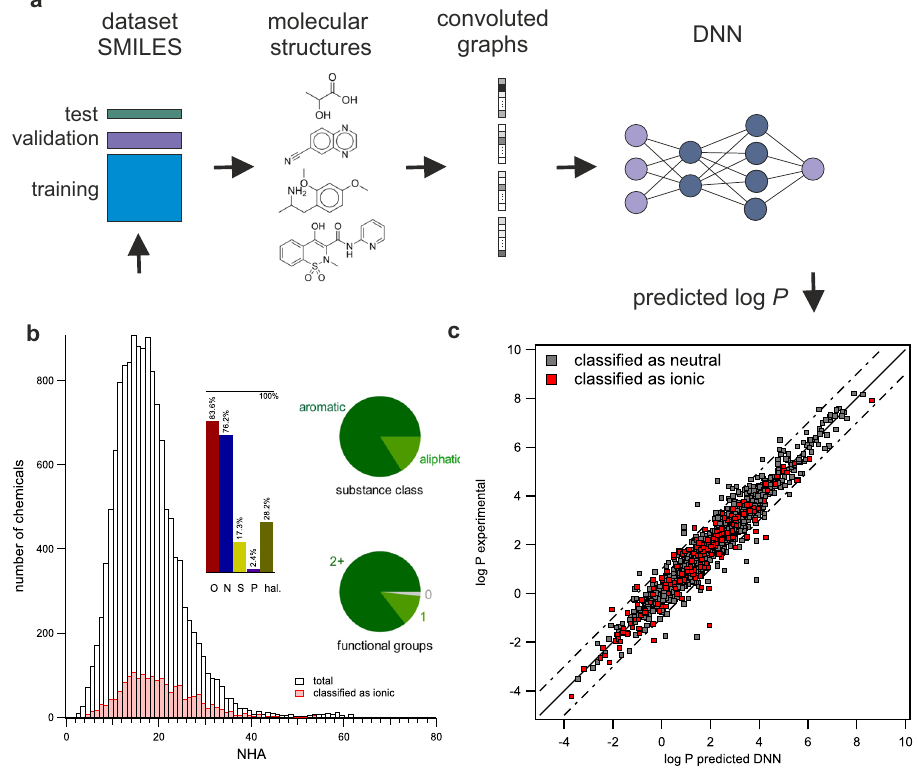
Fig. 1 DNN development for prediction of log P . a The log P dataset was randomly split in training set, validation set and test set for DNN model development. The DNN is depicted schematically. b The dataset itself includes heterogeneous chemical structures, which can be characterized by the number of non-hydrogen atoms NHA, the number of functional groups, substance classes like aliphatic and aromatic chemicals as well as heteroatoms (O — oxygen, N — nitrogen, S — sulfur, P — phosphorous, hal. — halogens fl uorine, chlorine, bromine, and iodine) included in the chemical ’ s structure. Further we distinguish between potential ions or neutral chemicals. c DNN prediction for the randomly selected test set (DNN taut applied). In gray neutral chemicals are depicted, in red potential ions (anions, cations, and zwitterions) are